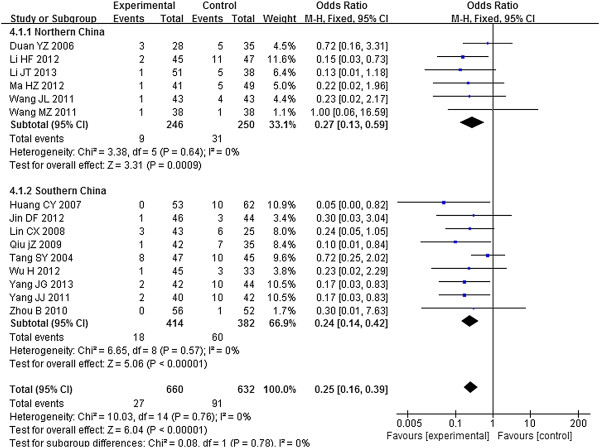
The forest plot of infection rate.